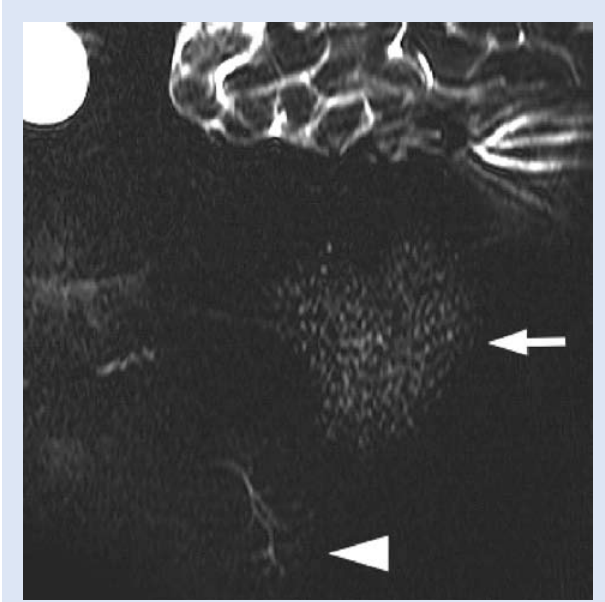
Fig. 1. MR sialogram (TR 8 000 msec, TE 1 000 msec, FOV 150 mm, SPIR fat suppression, slice thickness 40 mm, scan time 8 sec on 3T scanner). Numerous microcysts in parotid gland (arrow) without associated duct dilatation. These changes were identical in the other parotid gland. A few small microcysts were also noted in the submandibular gland (arrowhead), with the ducts also